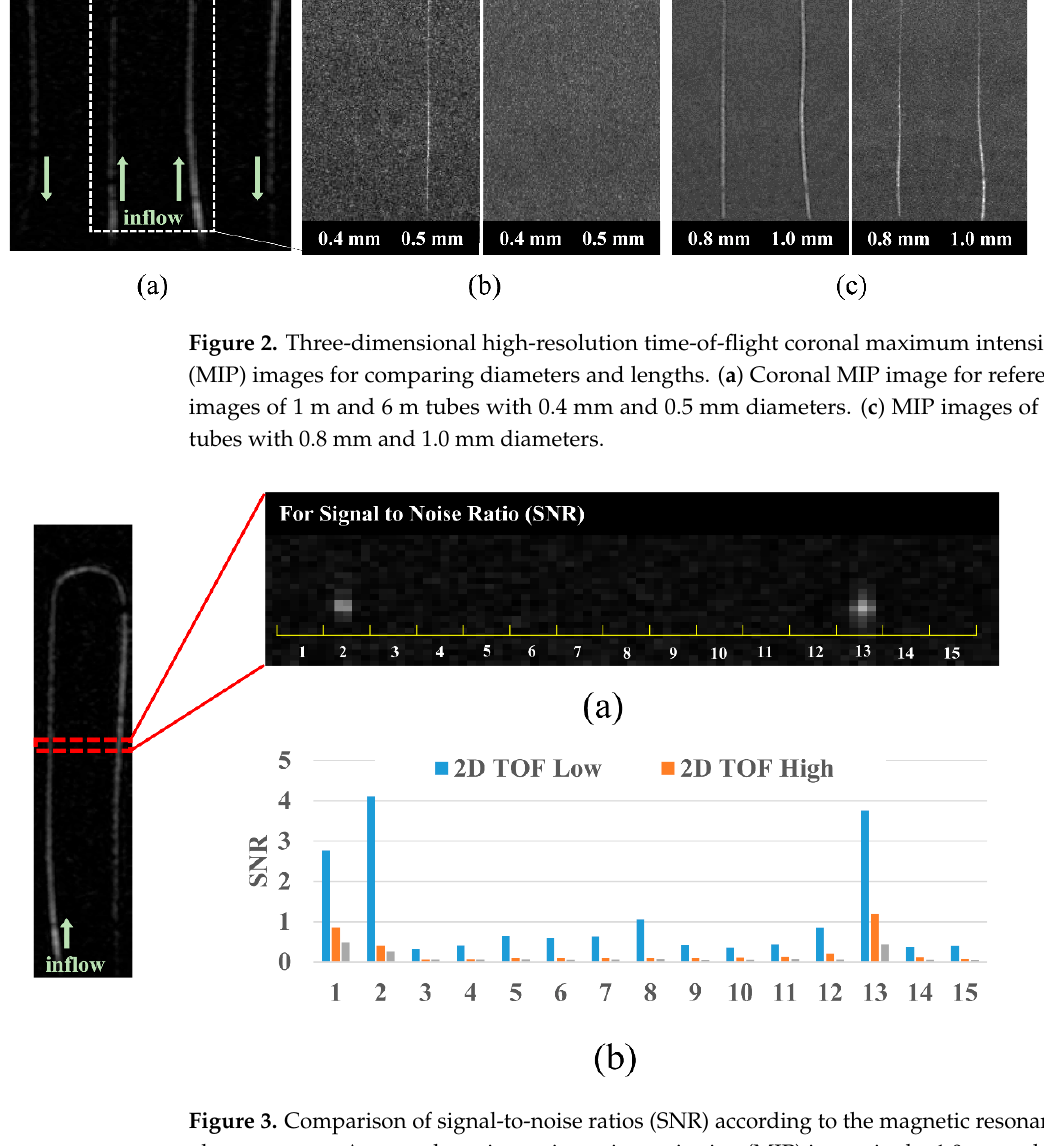
Figure 4. Microvascular phantom images for the reproducibility of the flow system. A coronal max- imum intensity projection (MIP) image in the 0.8 and 1.0 mm tube diameters is provided for refer- ence (left). ( a ) Seven axial MIP images of the 0.8 mm tube and ( b ) 1.0 mm tube. Table 5. Average signal intensity of seven PC 2D MRA images. Tube ID (mm)